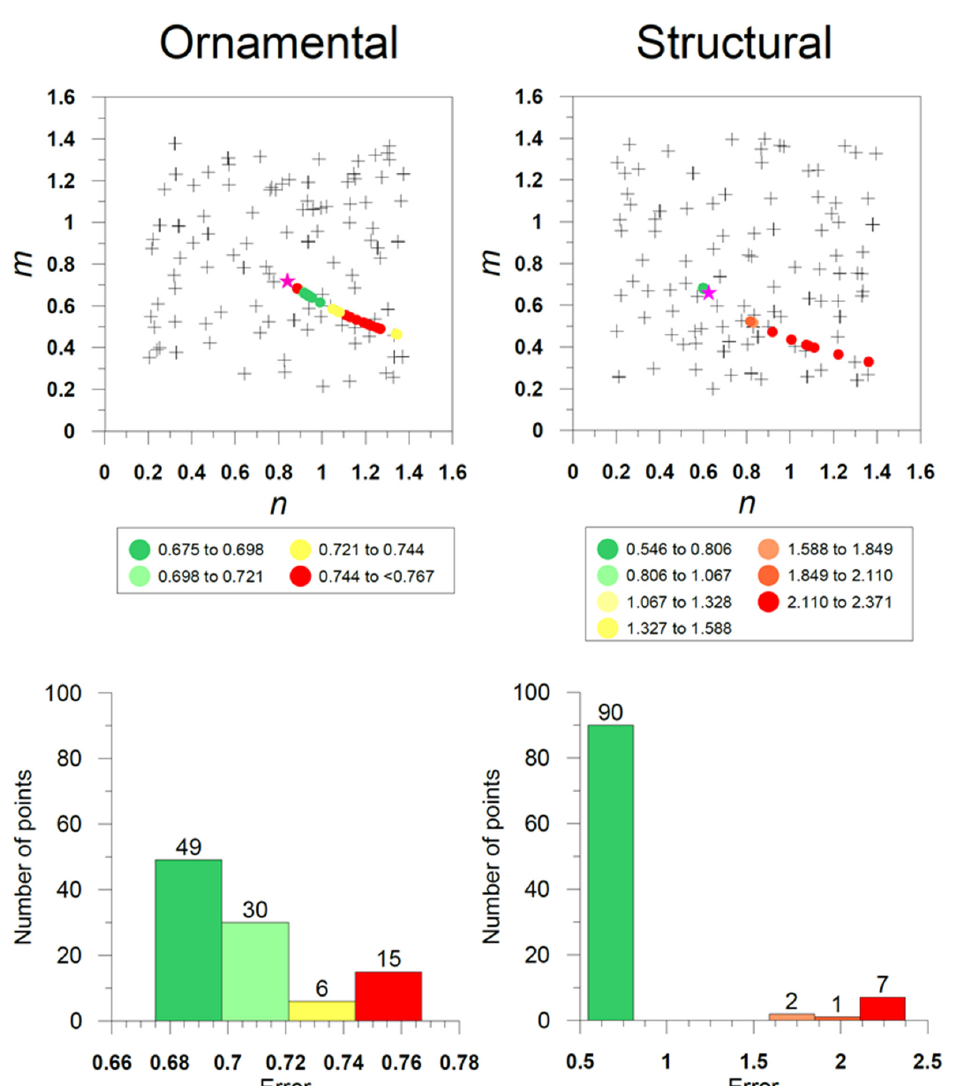
Figure 3. Results of the minimization algorithm (coloured dots) when starting at 100 different points (black crosses). The colour scale shows the error value associated with each point. The pink star indicates the vector of estimated parameters in [1]. Histograms of the errors of each minimum point.